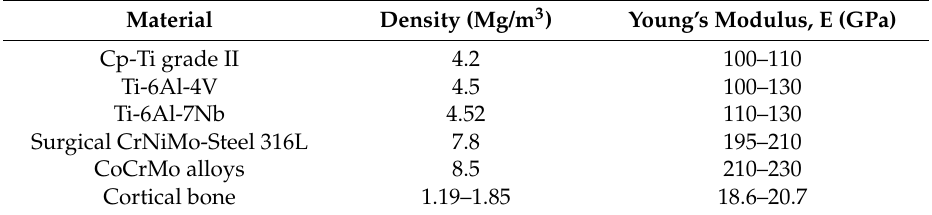
Table 1. Different metal alloys and their density and Young’s modulus in comparison to bone [2–6].